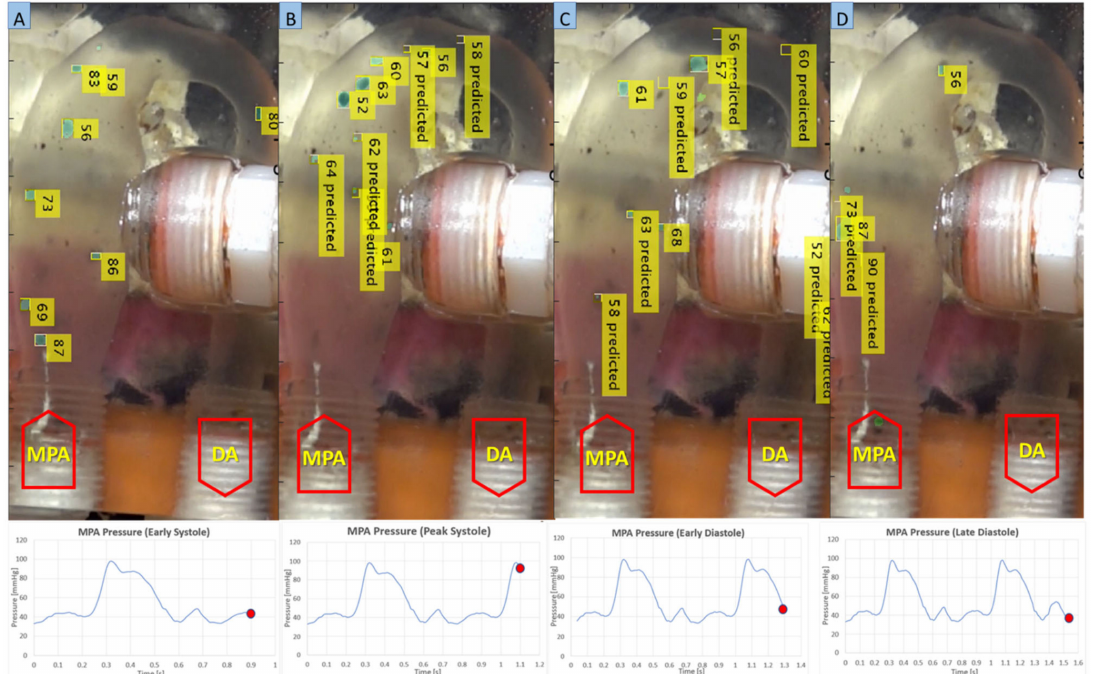
Figure 24. Tracked particles in the MPA conduit at different phases of the cardiac cycle ( A ) = Early systole, ( B ) = Peak systole, ( C ) = Early Diastole, ( D ) = Late